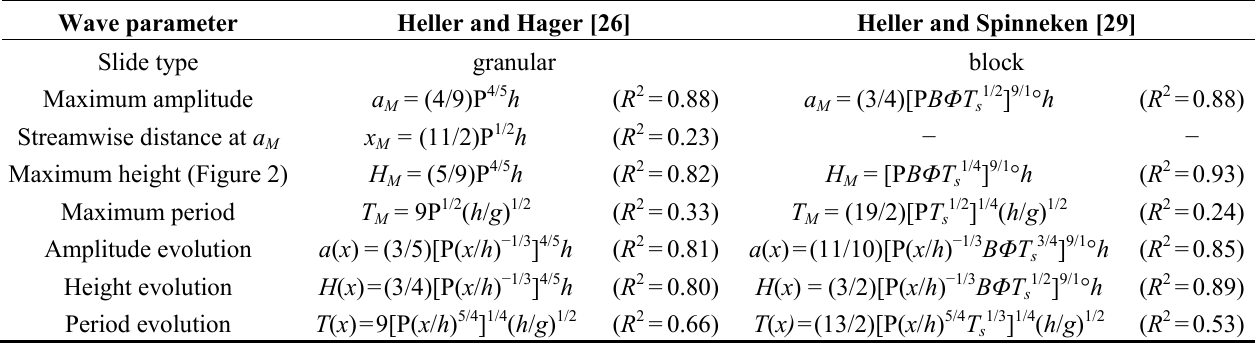
Table 1. Empirical equations based on P derived in 2D physical model studies by Heller and Hager [26] and Heller and Spinneken [29]; maximum wave height H correspond to the identical wave and location x was measured; for block model slides the blockage ratio B = b expression Φ = sin 1/2 φ (0.71 − 1.00) considering the slide front angle φ and the expression T = t /{[ h + V /( sb )]/ V } (0.34 − 1.00) considering the transition type are relevant, with s s s s s t = characteristic time of submerged landslide s